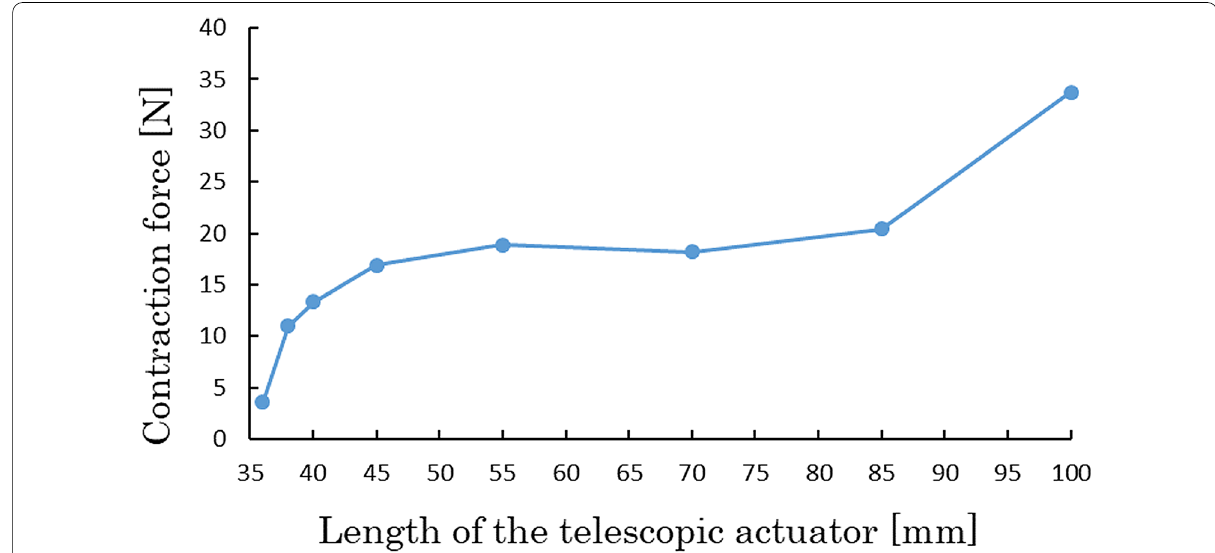
Fig. 5 Relationship between the contraction force of the telescopic actuator when the inside air pressure is The contraction force was almost constant when the length was in the range of 45–85 mm, which was due to the fact that the telescopic actuator changed its length significantly from atmospheric pressure to approximately air pressure was nearly constant, resulting in a constant contraction force. A steeper increase over 85 mm could be attributed to the change in the cross-sectional area by dents on the surface of the